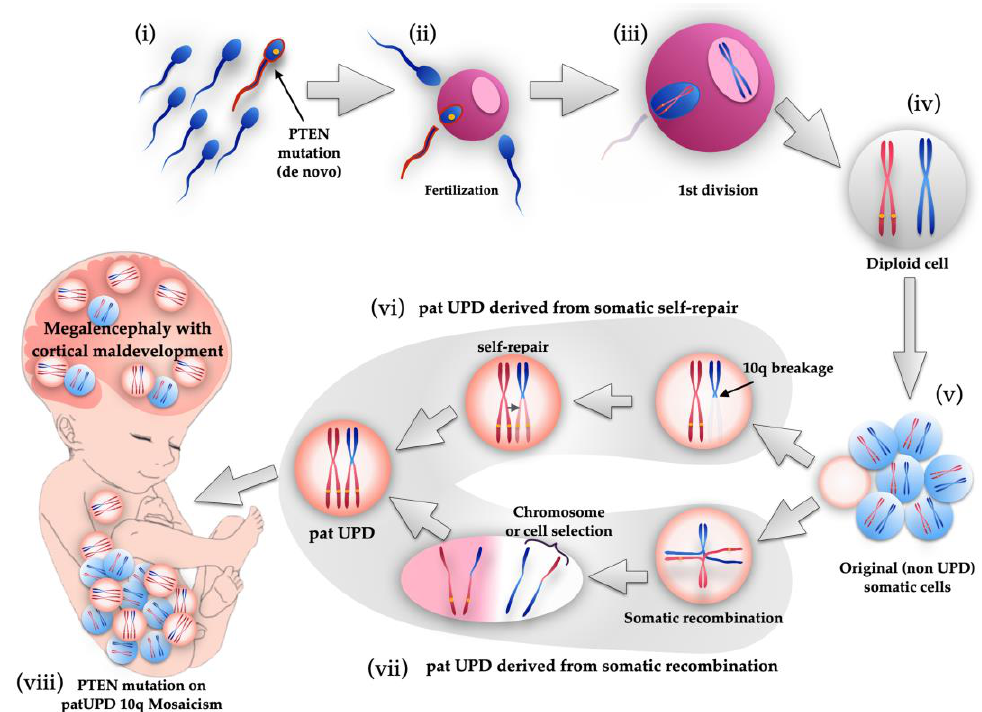
Figure 5. Schematic illustration of genetic events of fetus with PTEN mutation on paternal UPD 10q mosaicism. First, de novo PTEN mutation occurred in a sperm ( i ), and it fertilized an egg ( ii ). After first division ( iii ), diploid cell was created with PTEN mutated paternal and wild-type maternal chromosomes ( iv ). After that, somatic cells proliferated by mitosis, but UPD mosaicism cells were not yet produced at this stage ( v ). During mitosis, two possible genetic events cause the appearance of paternal UPD cells. One theory is 10q breakage and self-repair ( vi ). Another theory is somatic recombination and subsequent chromosome selection or cell selection ( vii ). Therefore, a fetus with paternal UPD 10q mosaicism with PTEN mutation was created, manifesting megalencephaly and cortical maldevelopment ( viii